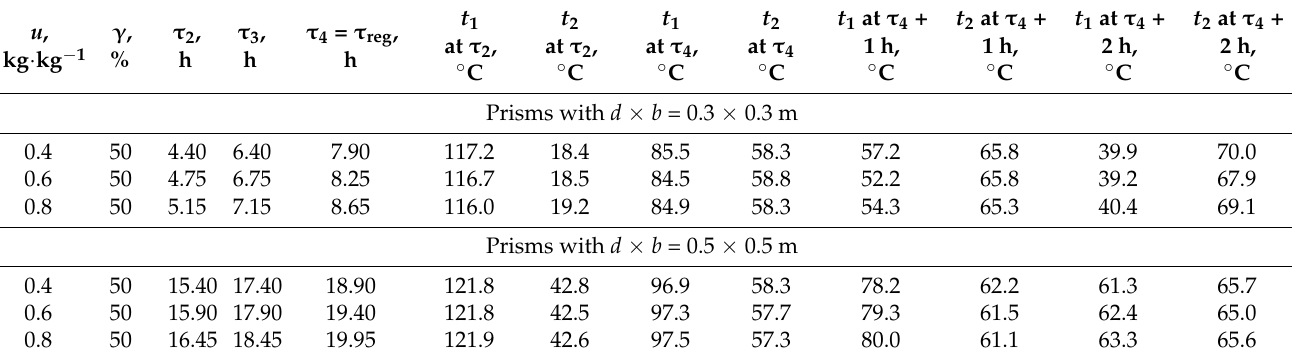
Table 2. Change in the Duration of the Steaming Regimes τ reg for Autoclave Steaming at t m1 = 130 ◦ C and γ = 50% of